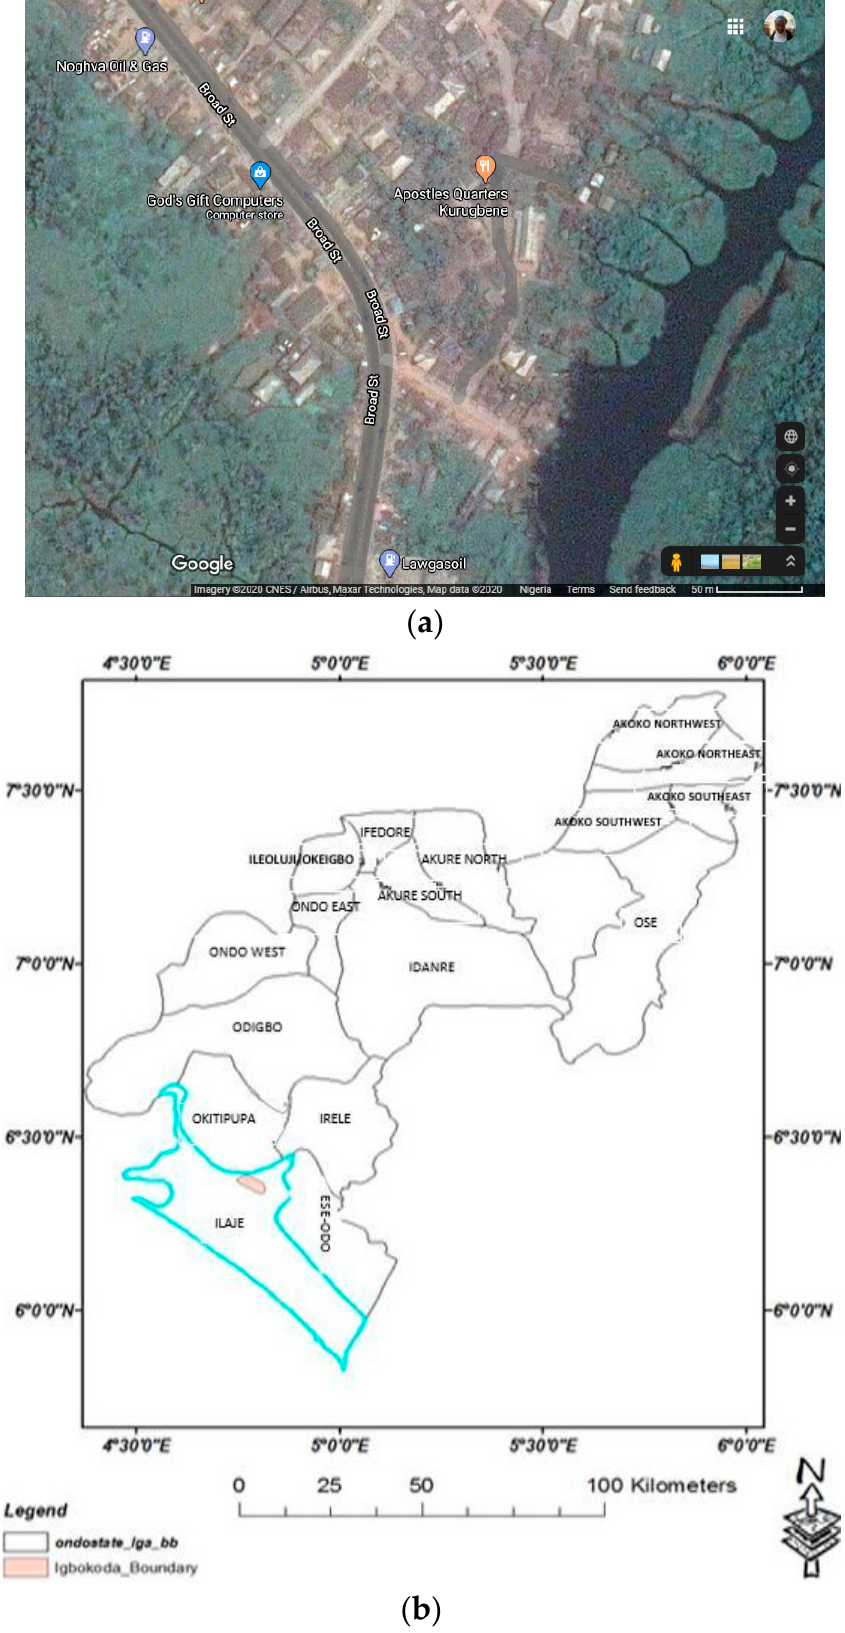
Figure 1. ( a ) Map showing the location of Igbokoda in the Ilaje local government area and within Ondo State. ( b ) Satellite image showing the broad street axis of Igbokoda where field work was conducted.